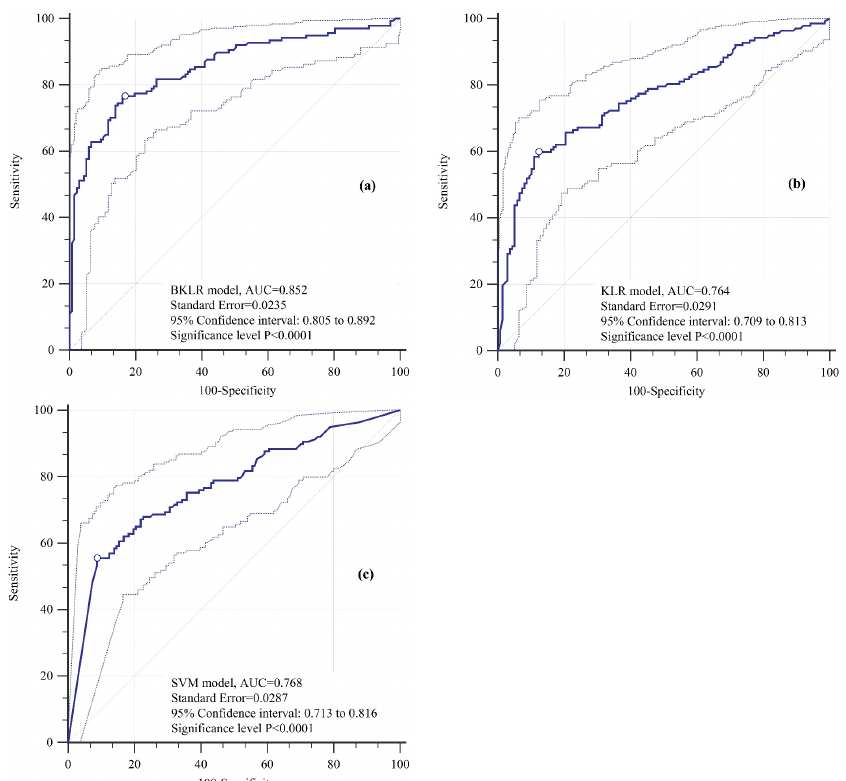
Figure 9. Receiver operating characteristics (ROC) curves using the training dataset: ( a ) BKLR